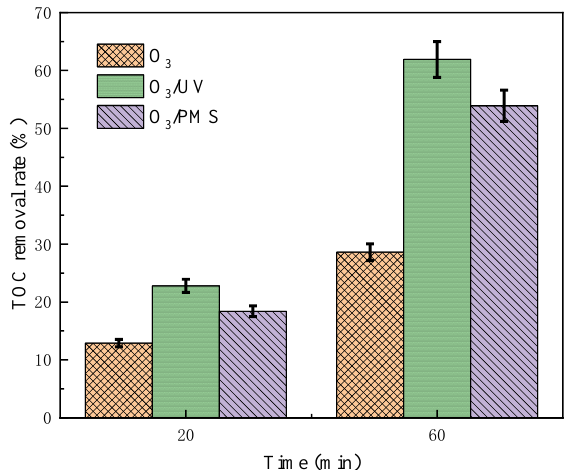
Figure 8. Mineralization effect of O 3 , O 3 /UV, and O 3 /PMS on SDZ (reaction conditions: pH = 6.8 ± 0.1, SDZ = 10 mg/L, O 3 = 3 mg/L, T = 25 ± 0.5 °C, O 3 = 3 mg/L, PMS = 22.8 mg/L).